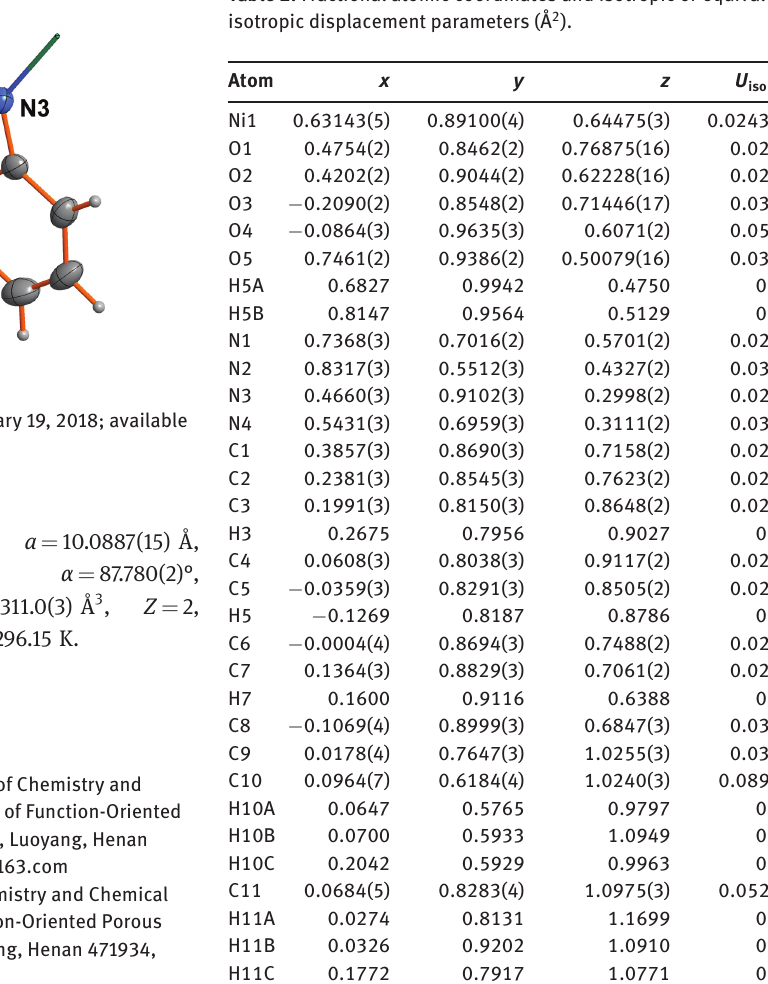
Table 2: Fractional atomic coordinates and isotropic or equivalent isotropic displacement parameters (Å 2